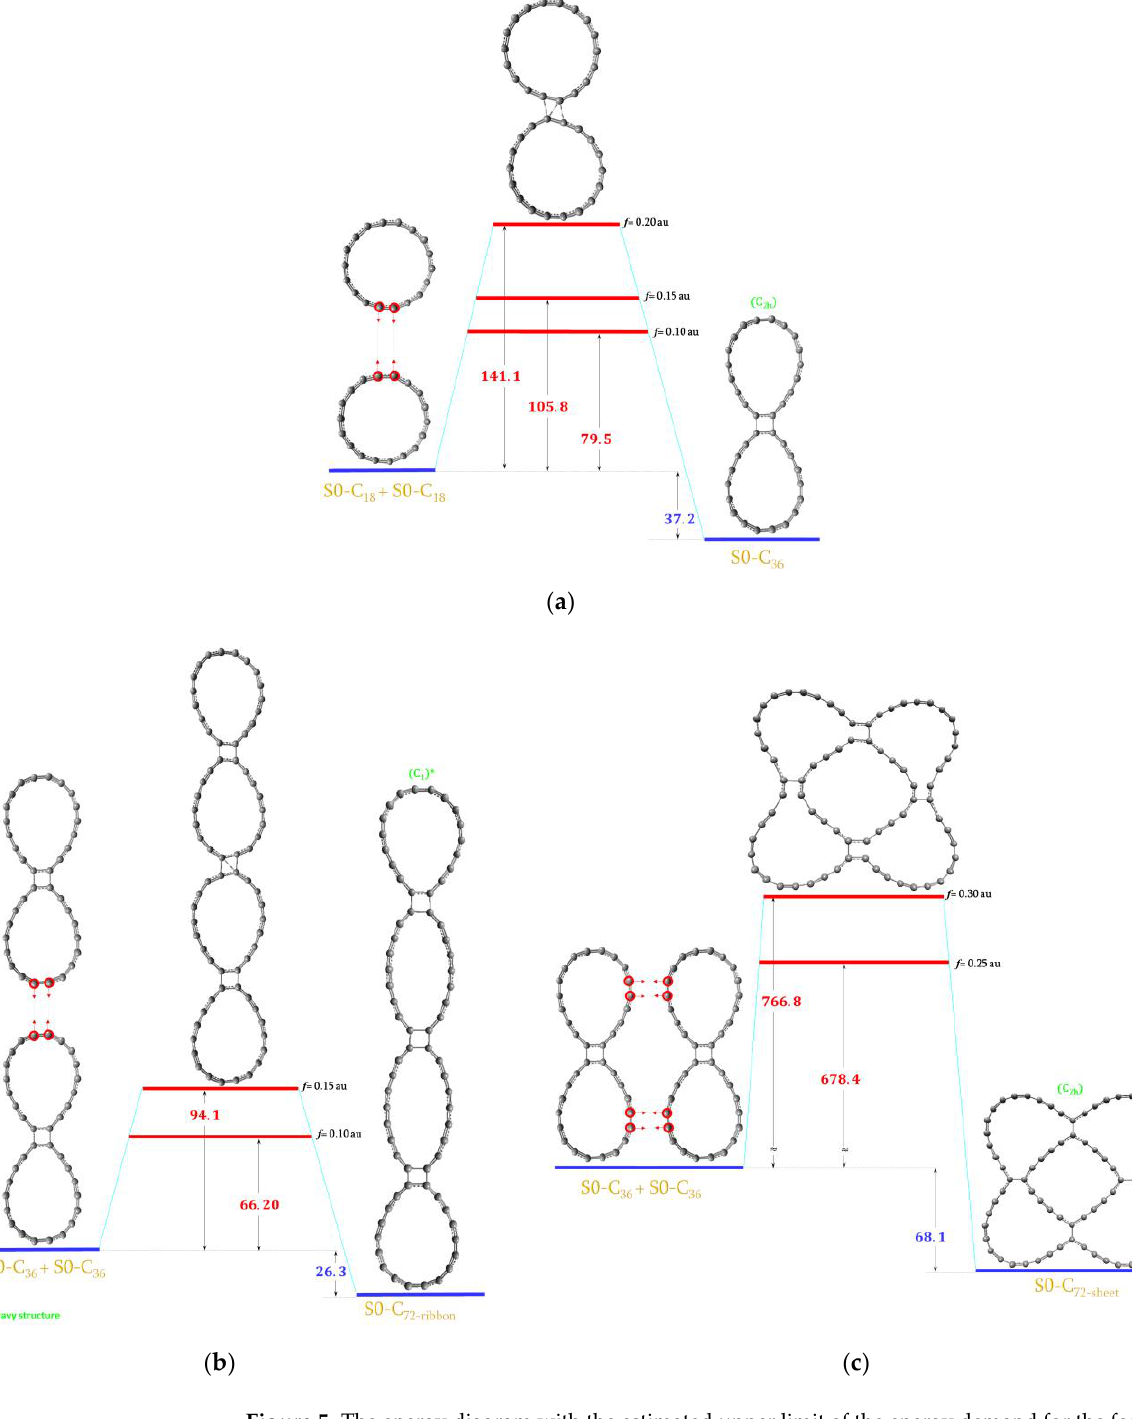
Figure 5. The energy diagram with the estimated upper limit of the energy demand for the for- mation of the ( a ) S0-C 36 molecule; ( b ) S0-C 72-ribbon molecule; ( c ) S0-C 72-sheet molecule. All values are in kcal/mol.